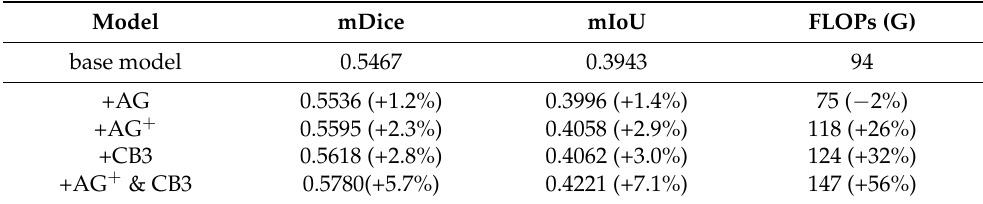
Table 3. Evaluate the effectiveness of each module in the proposed